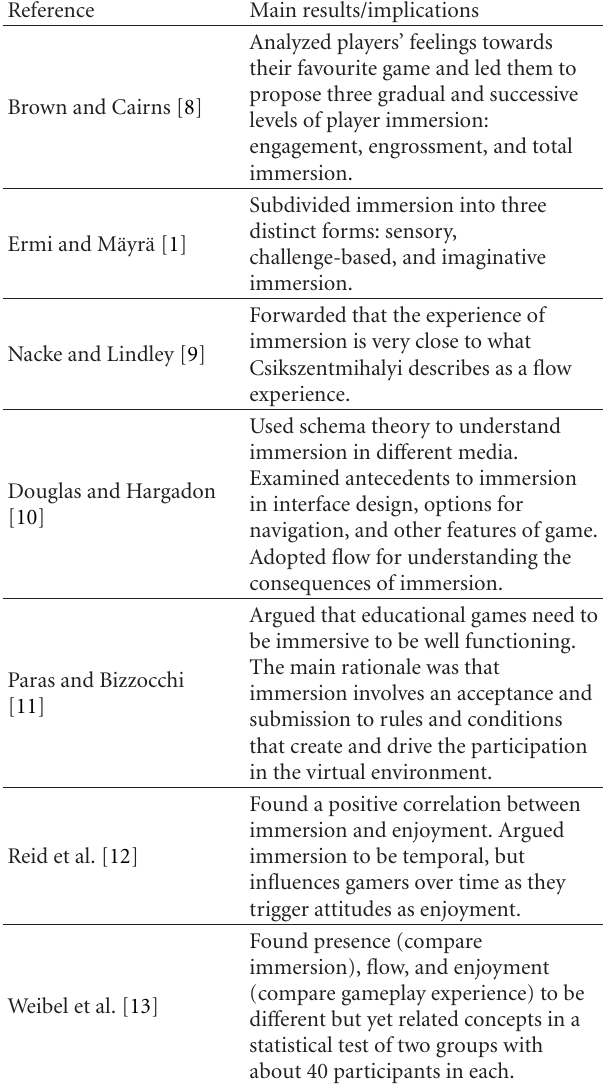
Table 1: Literature review of